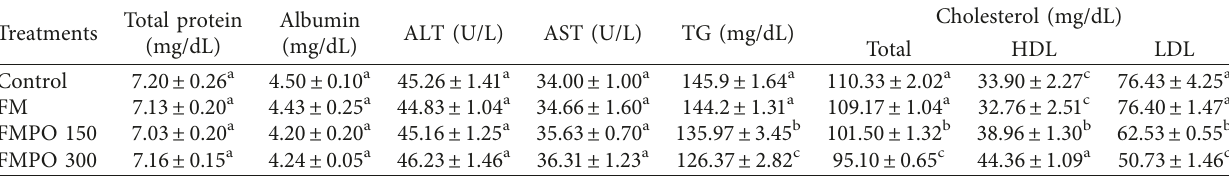
Table 7: Biochemical parameters of rats fed with and without functional fermented beverages.